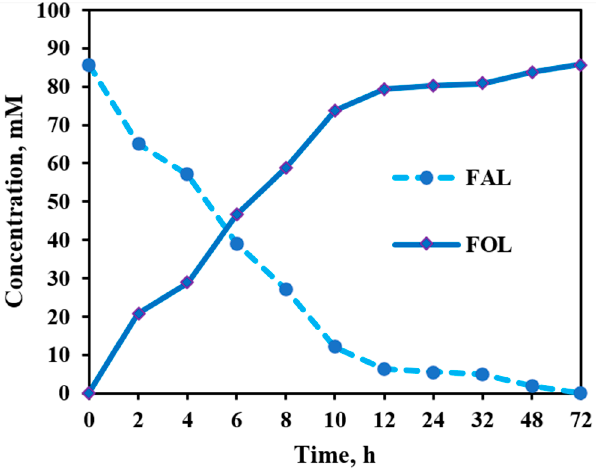
Figure 12. Time course of bioreduction of dilute corn stover-derived FAL with SF whole cells at pH 7.0 and 35 °C.